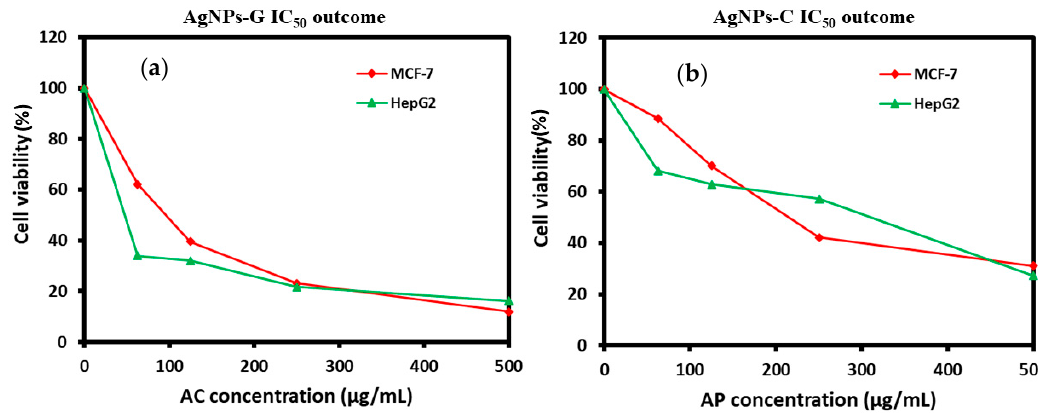
Figure 7. Viability outcome by MTT assay for ( a ) AgNPs-G and ( b ) AgNPs-C.